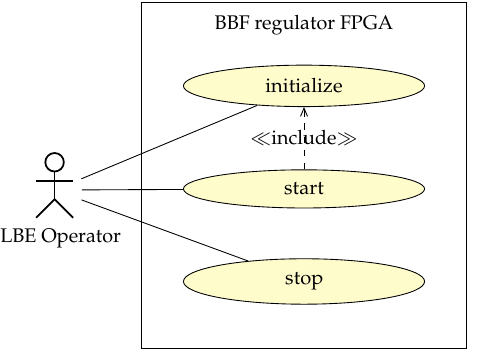
Figure 8. UML use case diagram summarizing user interaction with the BBF regulator FPGA.